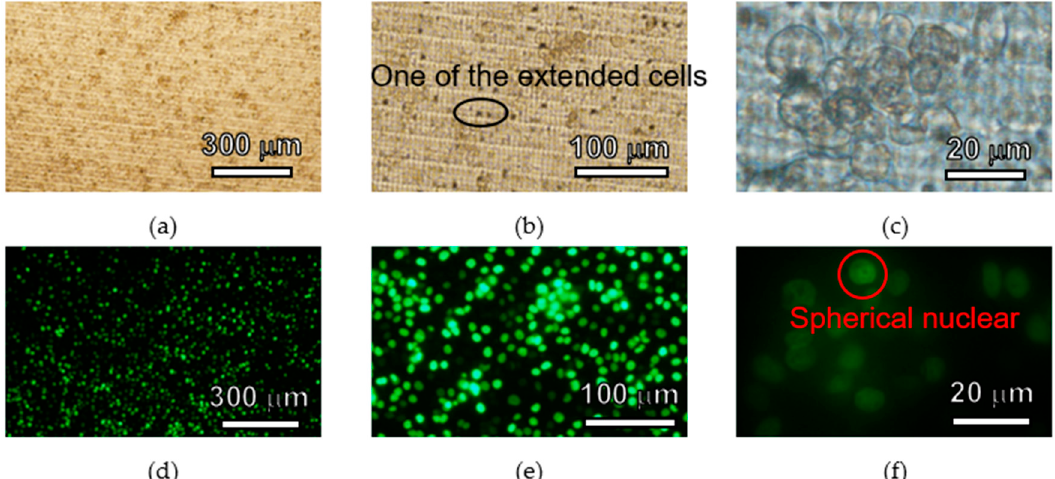
Figure 8. Images of HeLa cells cultured 4 days on the cell culture plate. ( a ) Bright field (×40). ( b ) Bright field (×100). ( c ) Bright field (×400). ( d ) Fluorescent (×40). ( e ) Fluorescent (×100). ( f ) Fluorescent (×400).